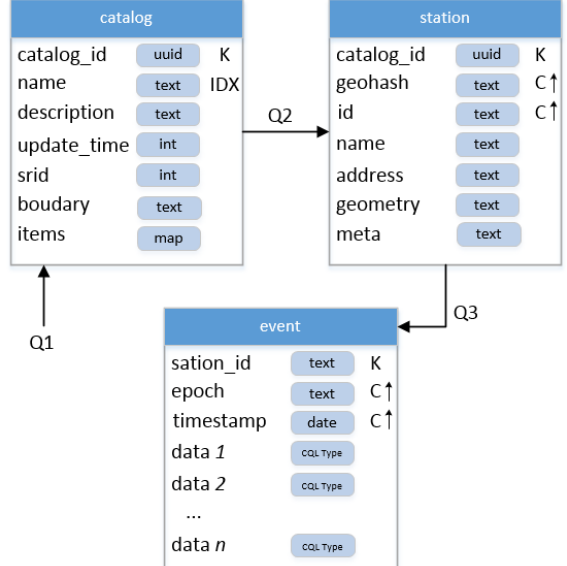
Figure 5: The physical data model for storing streaming data